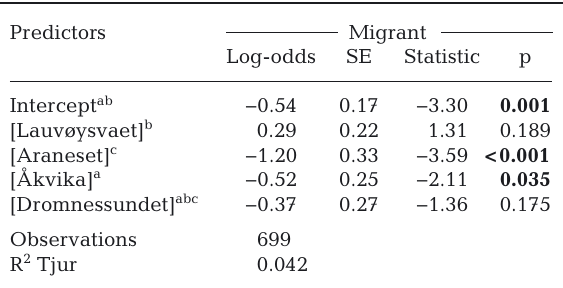
Table 5. Results of the generalized linear model showing dif- ferences between spawning grounds in the likelihood of de- tected cod being migrants, i.e. fish that were not released on the spawning ground in question. Square brackets indicate a categorical variable.The treatment contrast of R was used with the intercept representing the value for Glasøysvaet and the value for the other spawning grounds showing how they compare to this reference value. The letters show the results of Tukey post hoc tests, with different letters indi- cating significant differences (p < 0.05) between spawning grounds; significant p-values are shown in bold